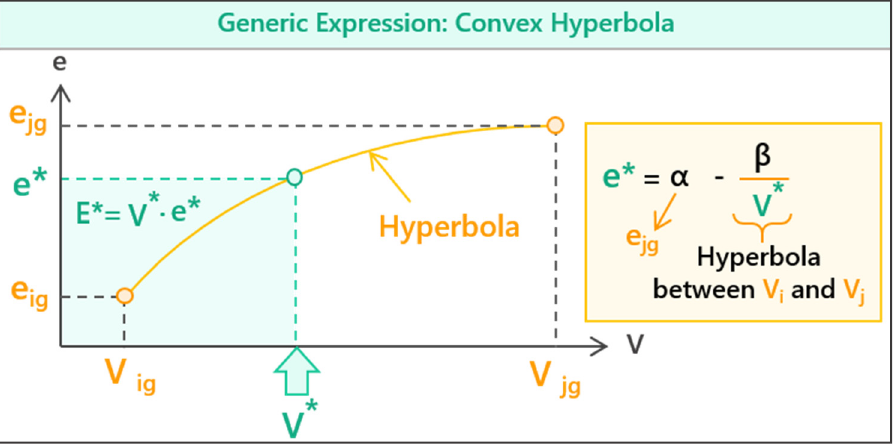
Figure 9. Generic expression of the specific energy e*: Convex Hyperbola.